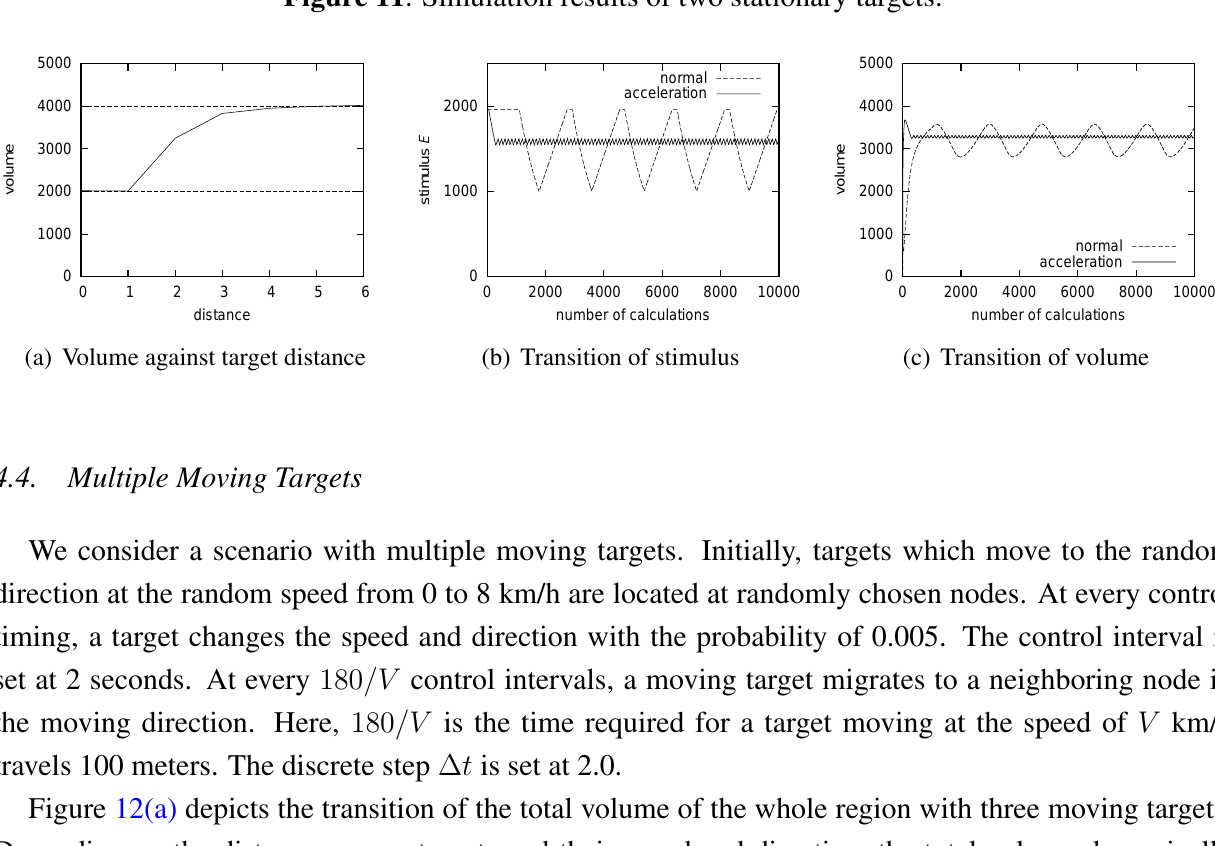
Figure 11 . Simulation results of two stationary